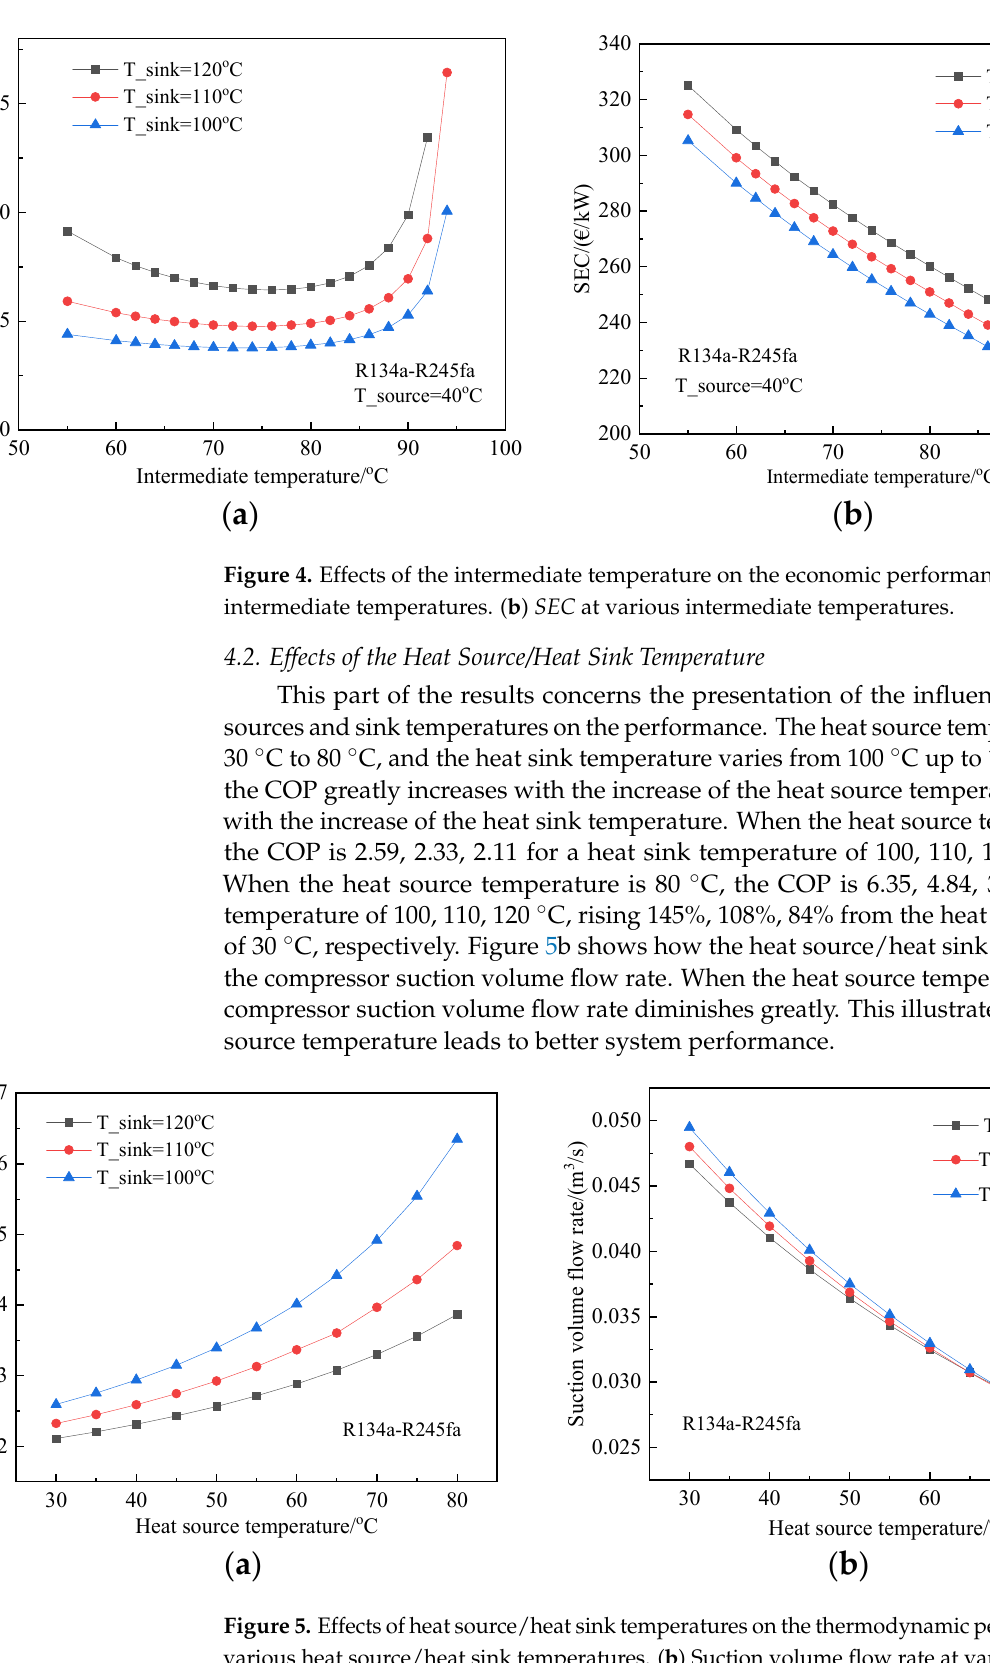
Figure 5. Effects of heat source/heat sink temperatures on the thermodynamic performance. ( a ) COP at various heat source/heat sink temperatures. ( b ) Suction volume flow rate at various heat source/heat sink temperatures.